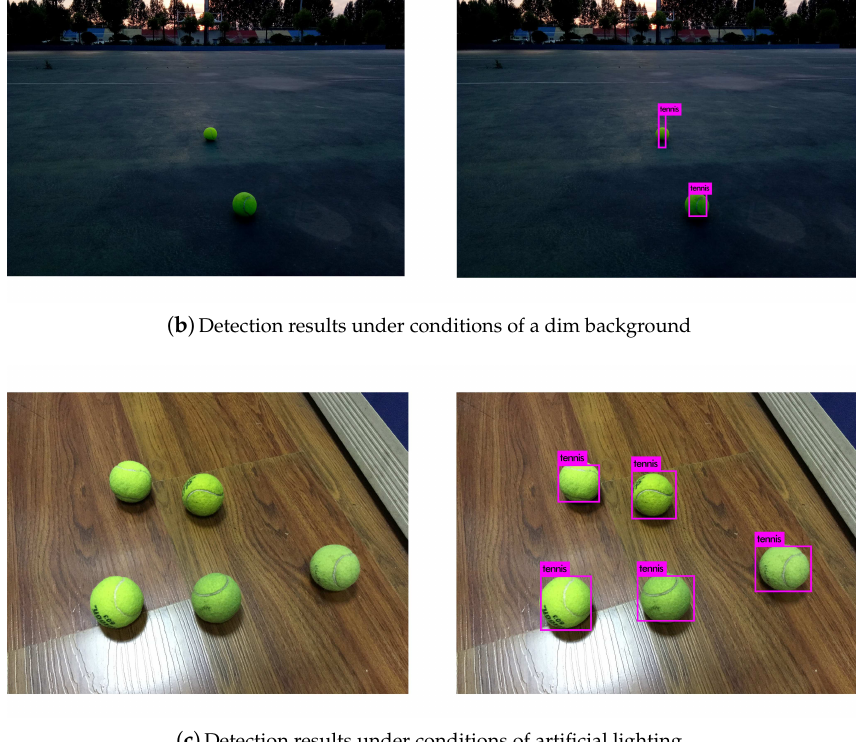
Figure 18. Detection results of the improved model under different lighting